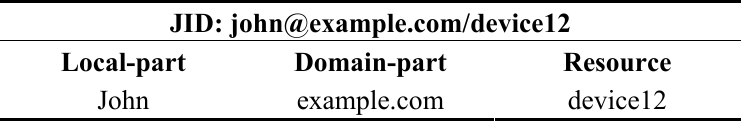
Table 1. An example of Extensible Messaging and Presence Protocol Jabber ID (XMPP